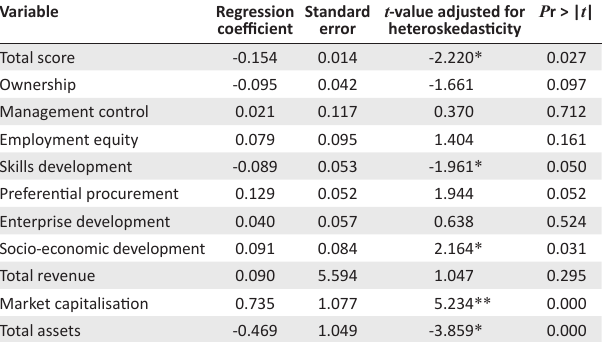
TABLE 8: Price/earnings ratio and total Broad-Based Black Economic Empowerment score and individual elements. Variable